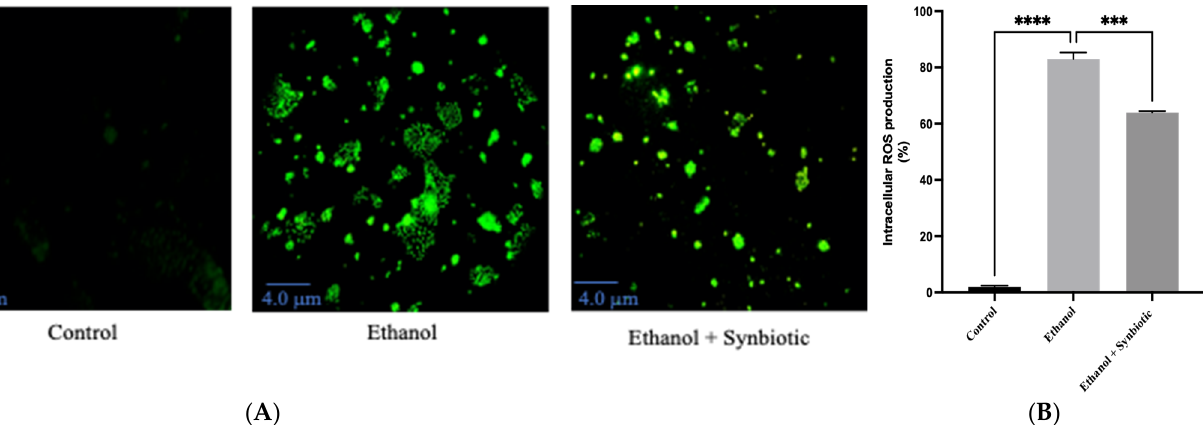
Figure 8. ( A ) Synbiotic (AGE + Lactobacillus rhamnosus ) affects ethanol-induced intestinal dysbiosis when used alone or in combination. ( B ) Fluorescence staining and spectroscopy at 485/525 nm were conducted following carboxy-H2-DCFDA incubation. The scale of the images is 4.0 μ m. The statistical analysis was calculated as mentioned in Section 2.10, *** p < 0.001, **** p < 0.0001.